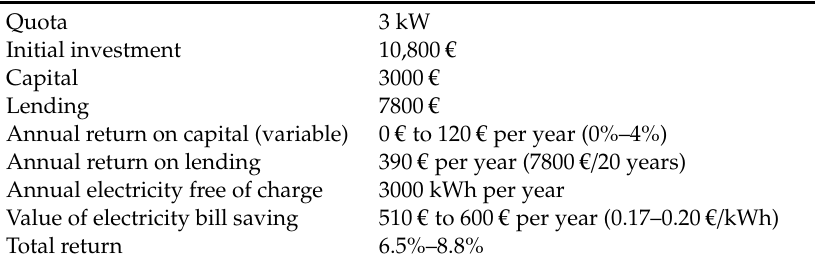
Table 4. Summary of Energyland o ff er and financial